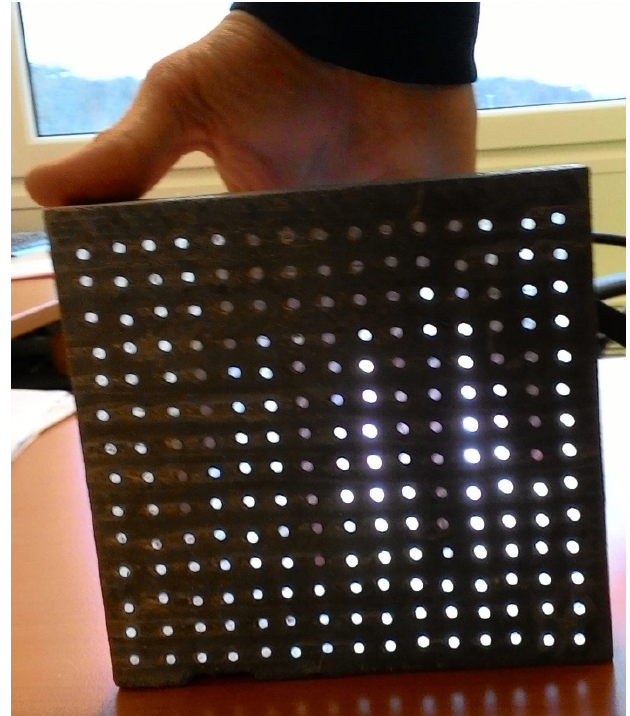
Figure 20. Example of light transmission through the slab.